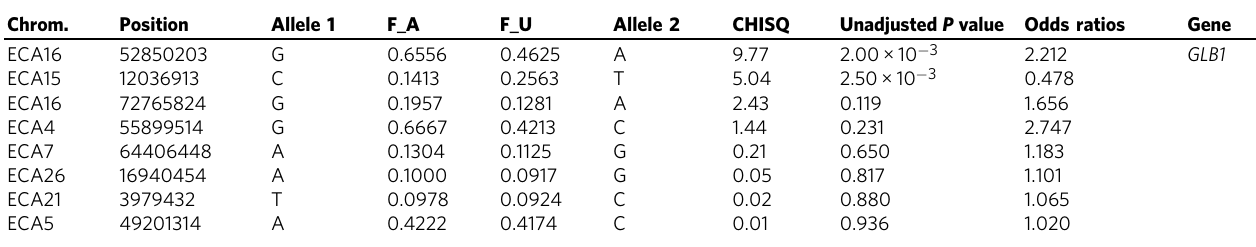
Table 5 SNPs signi fi cantly associated with the racing phenotype among Mongolian horses.